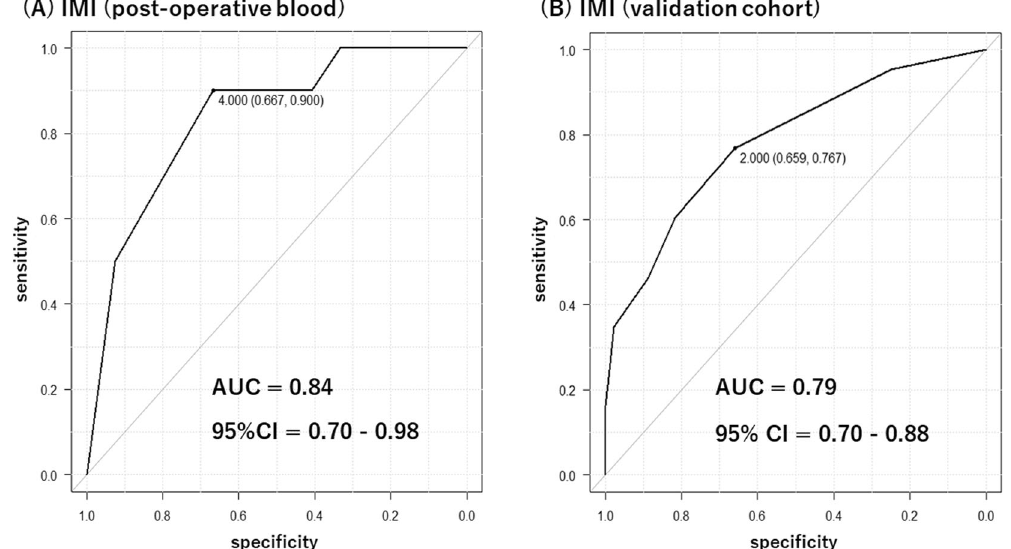
Fig. 1 ROC curves based on IMI. ( A ) ROC curve based on IMI in the current dataset. ( B ) ROC curve based on IMI in validation dataset from our previous